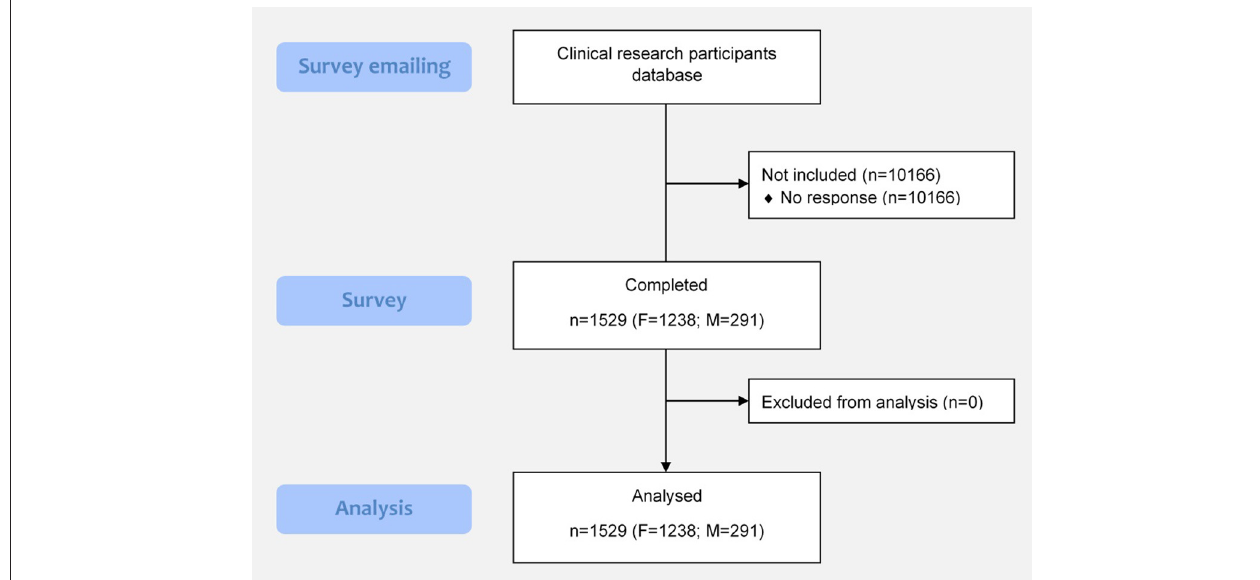
FIGURE 1 | Flow chart.